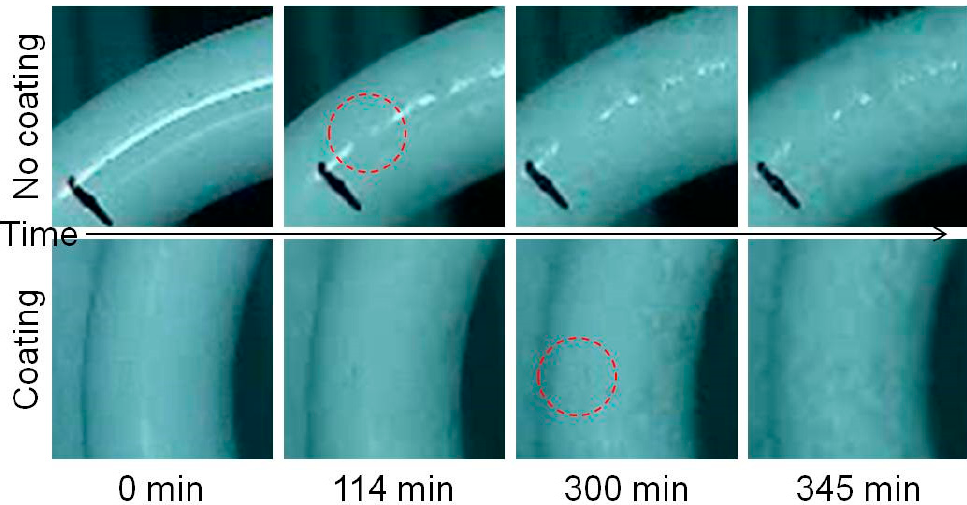
Figure 7. Frost formation process and variation of frost mass with different times for various surfaces: normal surfaces and PDMS-SiO 2 /PFA hybrid coating surfaces.